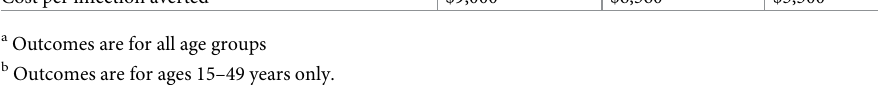
Table 3. Projected impact of the VMMC program over 2016–2030, with VMMC scale-up embedded within broader scale-up of HIV prevention and treatment, according to the global Fast Track targets, evaluated relative to the counterfactual scenario in which the Fast Track targets for other interventions are met without VMMC. Outcome Goals a ICL b EMOD a Number of infections averted 39,800 Number of VMMCs per infection averted Cost per infection averted $6,560 $5,500 a Outcomes are for all age groups b Outcomes are for ages 15–49 years